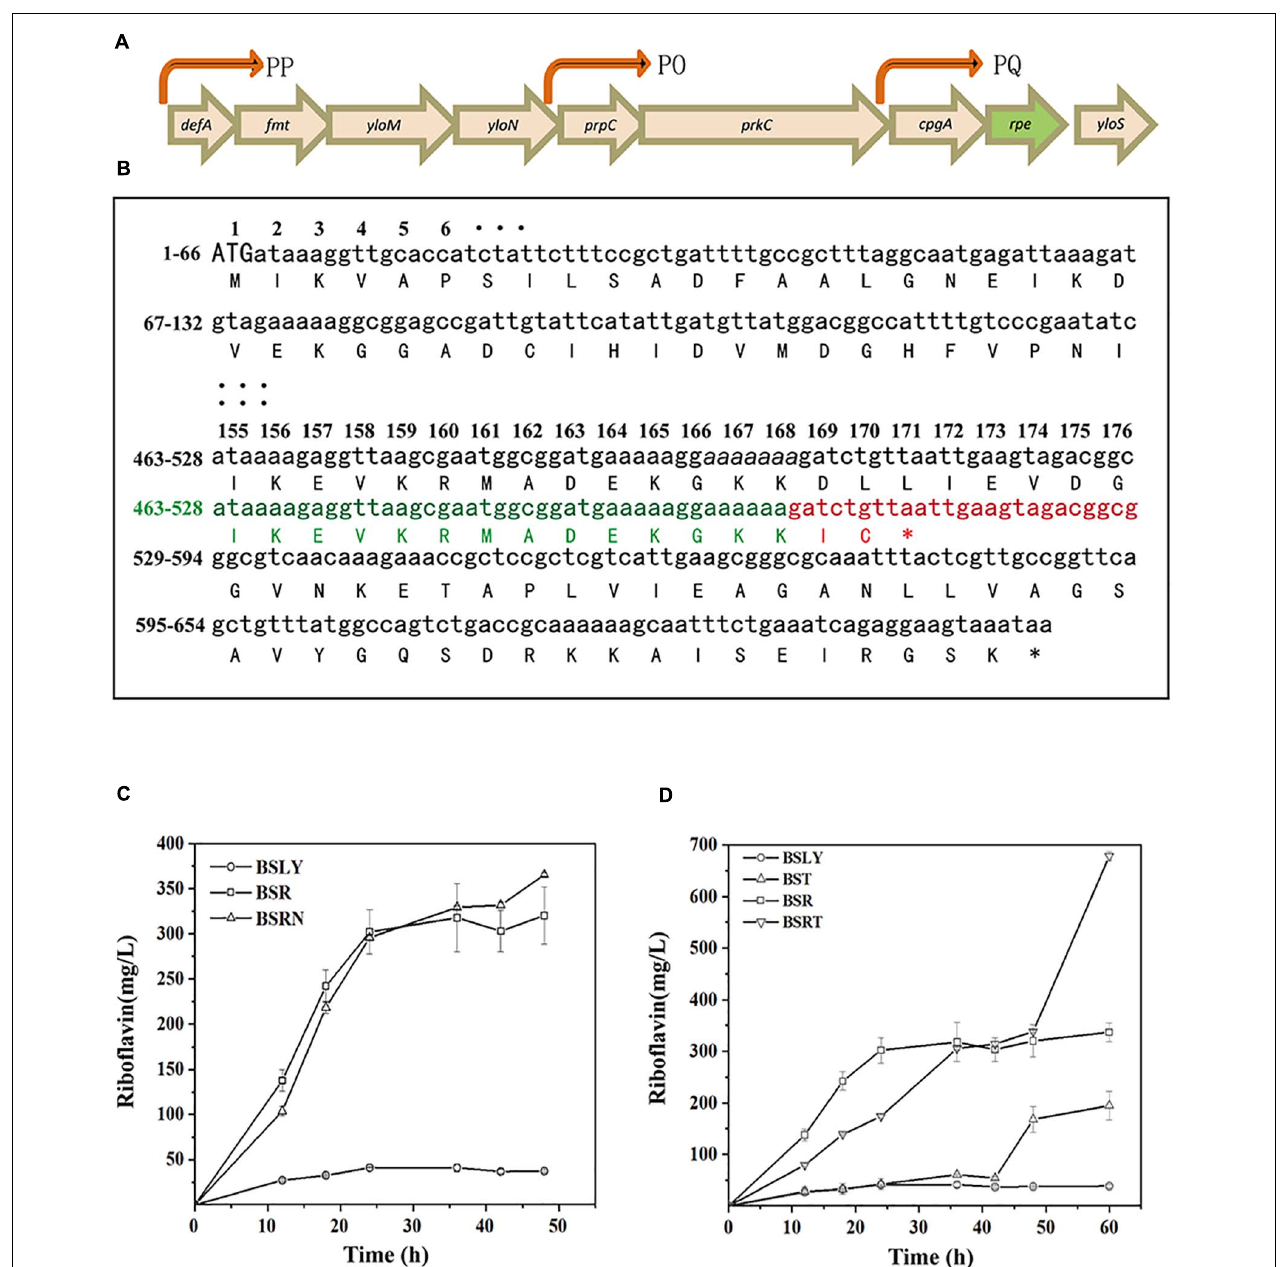
FIGURE 2 | Location and sequence of the rpe gene, and riboflavin productivity of rpe mutants. (A) Location of rpe and other eight genes of the operon on the genome. The arrows were indicated promoters (PP, PQ, and PO) confirmed in previous studies (Iwanicki et al., 2005; Hinc et al., 2006). (B) Nucleotides and amino acids sequence of the wild-type and mutant rpe . The numbers on the left indicate the start and stop nucleotide numbers of each line; the numbers on top are the amino acid numbers of the corresponding codons. Sequence of the wild-type rpe is shown in black, and adenines from positions 498 to 504 are shown in italics. Sequence of the mutant rpe gene is shown in green (identical with WT sequence) and red (shifted sequence), while the changed amino acids sequence of Rpe is also shown in red. (C) Comparison of riboflavin production between BSR ( rpe 504delA), BSRN ( rpe 0 ), and their parent strain. (D) Comparison of riboflavin production between BST ( tkt 0 ), BSRT ( rpe 504delA, (cid:49) tkt 0 ), and their parent